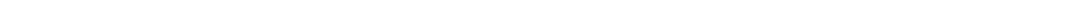
Fig. 5 CAF-S1 stimulate CD25 + FOXP3 + T lymphocytes. a Percentage of CD4 + CD25 + or CD4 + CD25 − lymphocytes migrating towards CAF-S1. Data are shown as mean ± SEM. n = 4 independent experiments. P values from Student ’ s t -test. b Percentage of alive CD4 + CD25 + or CD4 + CD25 − T lymphocytes in absence (Control) or presence of CAF-S1. Data are shown as mean ± SEM. n = 4. P values from Student ’ s t -test. c Density curves showing CXCR4 expression in CD4 + CD25 − (green), untreated CD4 + CD25 + (orange) or after culture with CAF-S1 (red), compared to control isotype (blue). Cell count is normalized, as percentage of maximal number of cells (% of max). d CXCR4 protein levels in CD4 + CD25 − or CD4 + CD25 + lymphocytes without (Control) or with CAF-S1. Speci fi c MFI are shown as mean ± SEM. n = 5. P values from paired t test. e CXCL12 α and CXCL12 β mRNA levels after silencing of CXCL12 α - or/and CXCL12 β in CAF-S1 cells. Data are shown as mean ± SEM of fold change to control. n = 5. P values from one sample t test. f Percentage of migrating CD4 + CD25 + lymphocytes after CXCL12 α / β silencing in CAF-S1 cells. Data are shown as mean ± SEM. n = 5. P values from paired t test. g Same as in ( f )